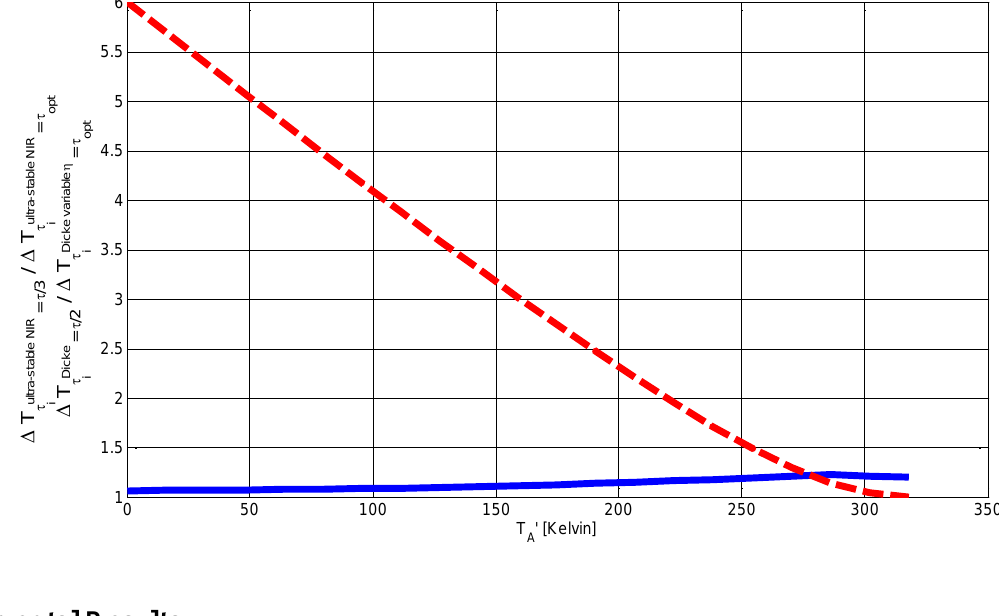
Radiometric sensitivity improvement by optimizing the observation times: ultra-stable (solid) and Dicke (dashed)